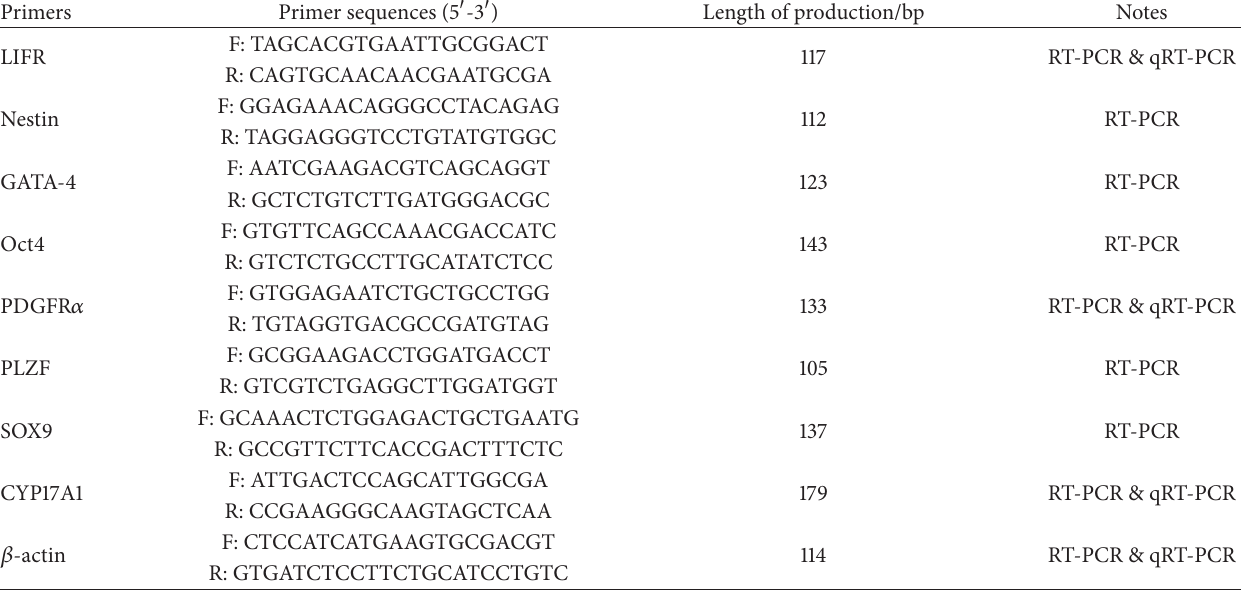
Table 1: Primer sequences for genes designed and used in this